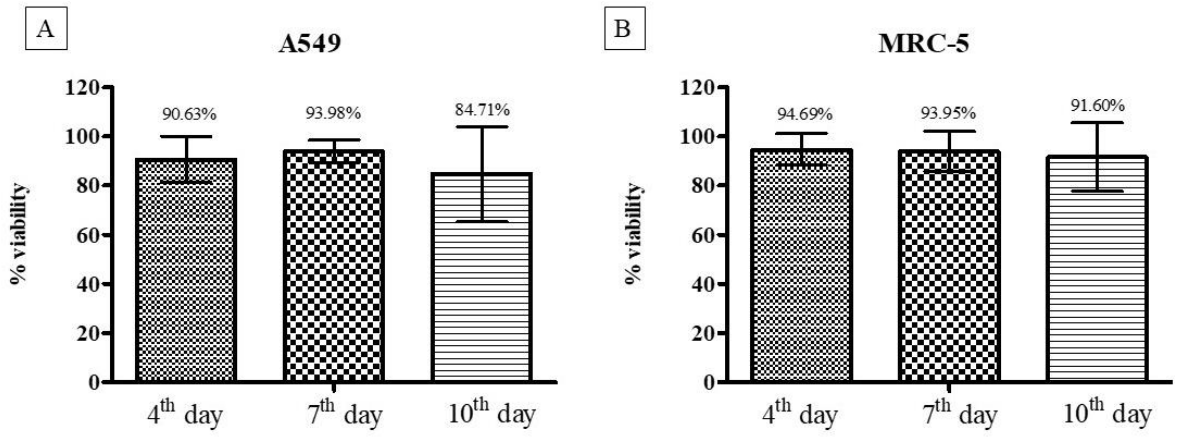
Figure 5. Cell viability using the resazurin method for the three-dimensional model of cell lines A549 ( A ) and MRC-5 ( B ). In both cell lines, the viability of the three-dimensional culture remained stable after ten days of culture. There was no statistically significant difference.